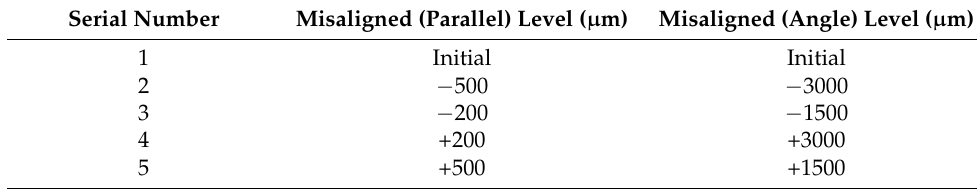
Table 3. Parameter setting of misalignment fault.